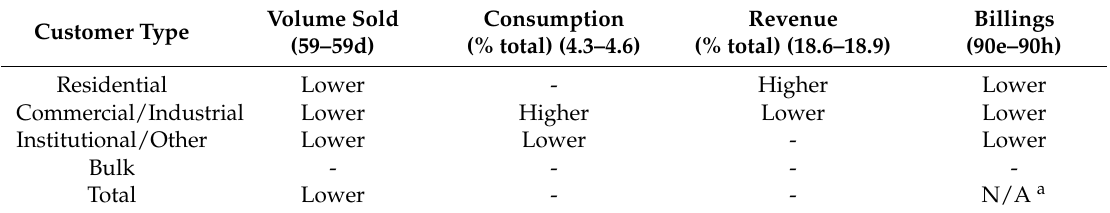
Table 4. Relationship between intermittency and customer type by measures of volume of water sold, consumption and revenue as a percent of the total, and water billings (summarized from Table